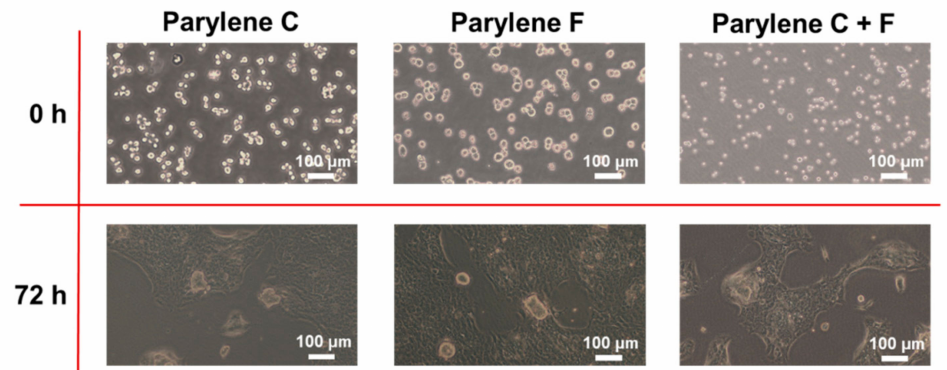
Figure 7. Comparison of the Parylene homopolymer and copolymer films in cell culture. The Parylene C and F copolymer films showed identical biocompatibility to the Parylene C